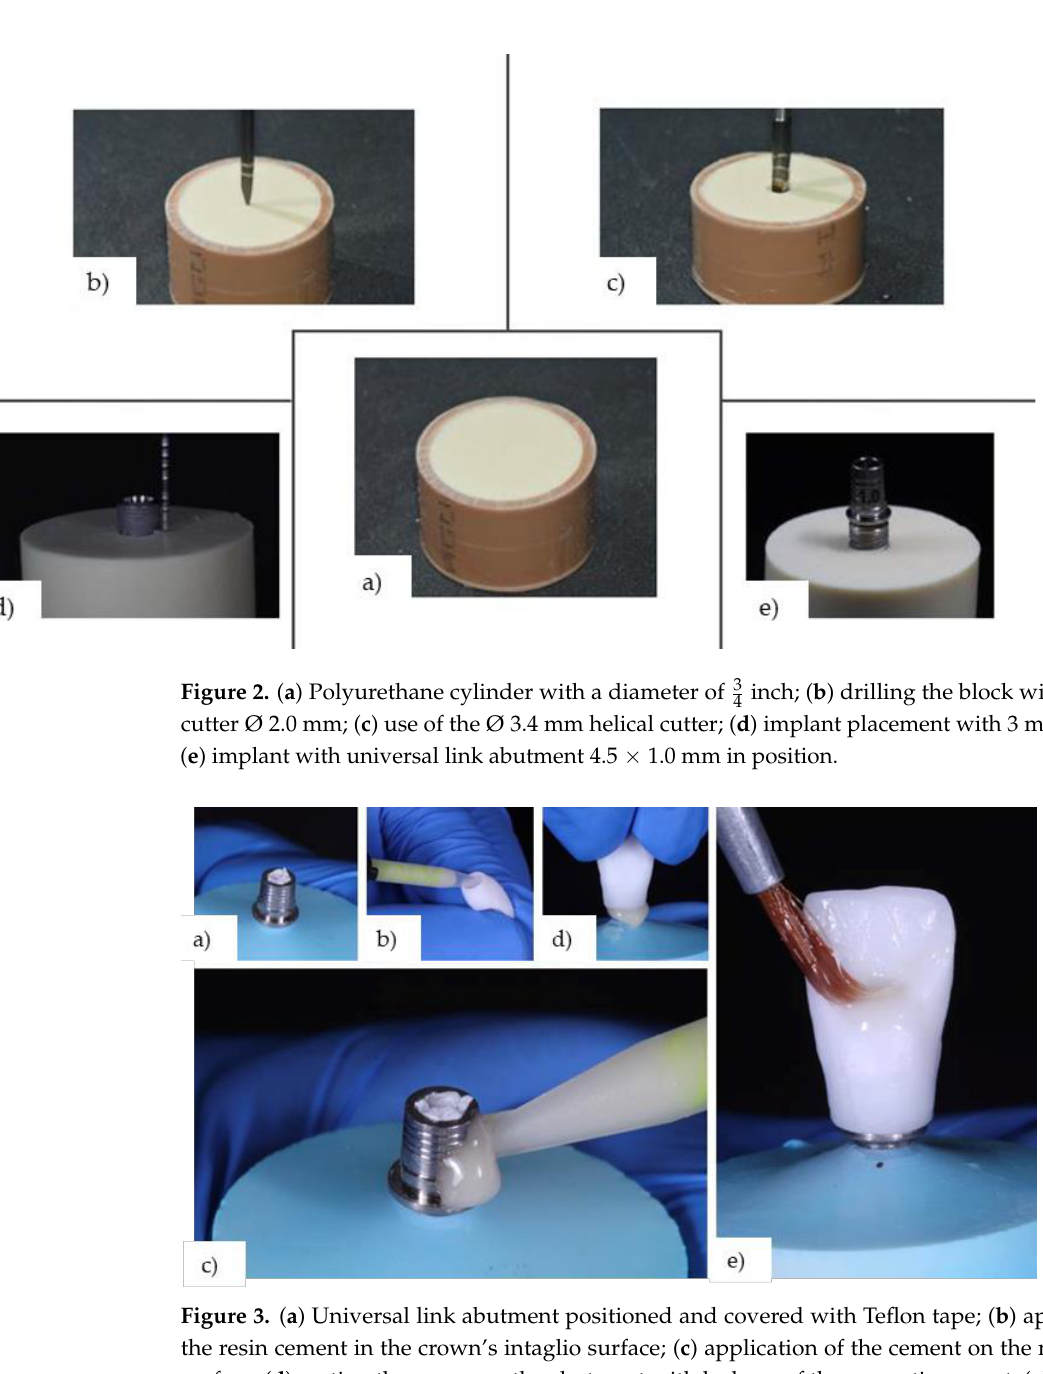
Figure 3. ( a ) Universal link abutment positioned and covered with Teflon tape; ( b ) application of the resin cement in the crown’s intaglio surface; ( c ) application of the cement on the metallic link surface; ( d ) seating the crown on the abutment with leakage of the cementing agent; ( e ) removal of excess cement.